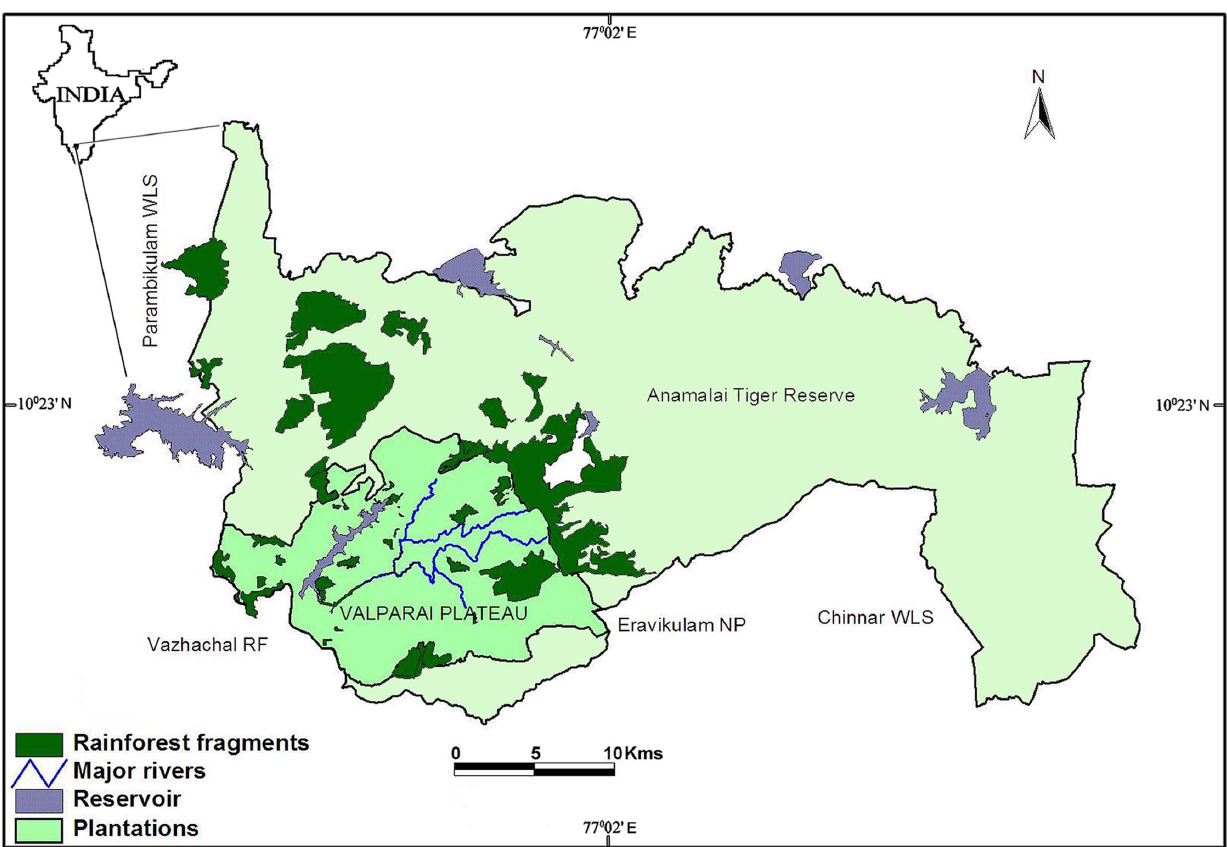
Figure 3. Rainforest fragments in Anamalai Tiger reserve, Western Ghats, India.